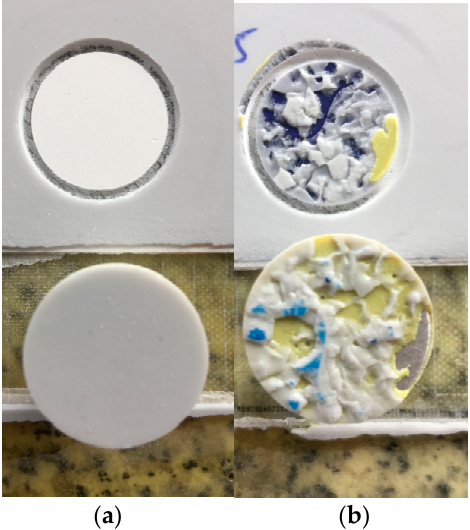
Figure 24. Pull-off strength testing of specimen laminates used for LEP coating adhesion: ( a ) adhesive failure with no-primer intermediate layer application; ( b ) cohesive failure with primer application (the dolly adhesive effect can also be observed).